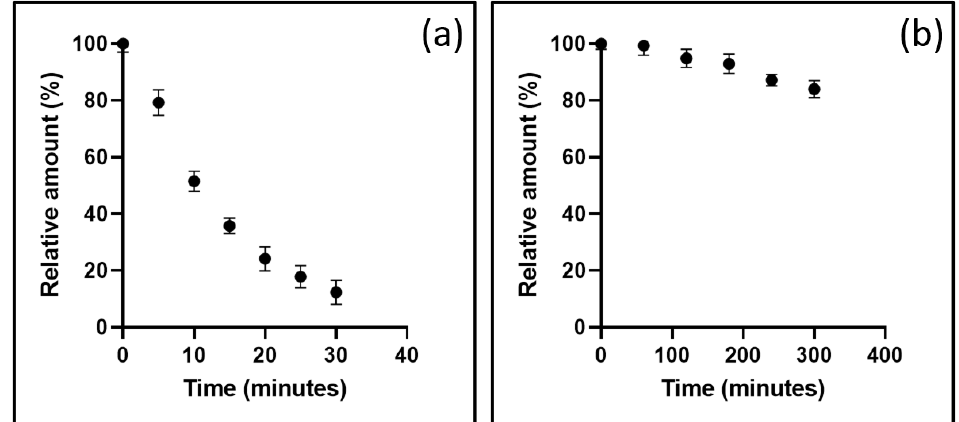
Figure 2. Evolution of selumetinib (relative amount) in solution under stress conditions (exposition to simulated light at 25 °C) (inset ( a )) and in the presence of H 2 O 2 (3%) at 40 °C (inset ( b )).